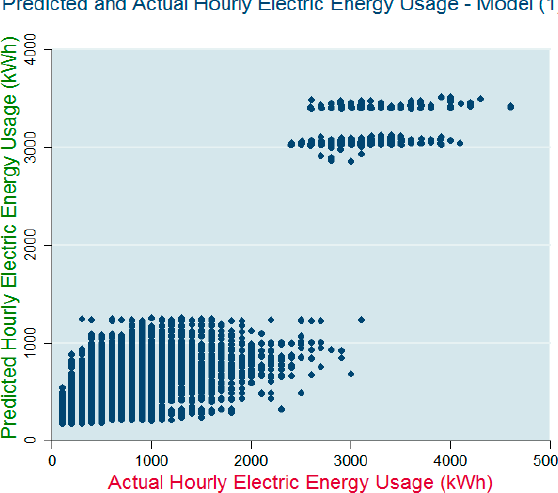
Figure A1. The correlation between predicted and actual hourly usage in the summer experiment.